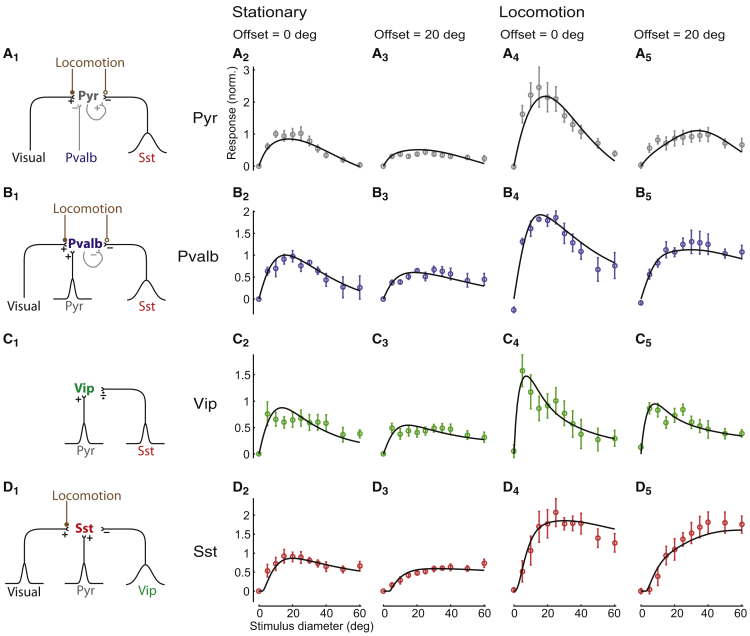
A Recurrent Network Model Accurately Predicts the Visual Responses of Each Cell Type(A1) Input synapses received by Pyr cells and their modulation by locomotion. Pyr cells receive feedforward visual excitatory inputs (e.g., from thalamus or other cortical layers) and subtractive inhibition from Pvalb and Sst cells. Locomotion increases the synaptic weights from external visual inputs to Pyr cells (filled circles) while decreasing recurrent Pyr-to-Pyr connections (empty circles). Pyr cells integrate from a broad pool of Sst cells (large Gaussian curve). Gray indicates connections that could be mathematically integrated out in the model when computing effective connections.(A2–A5) Model fit (black curves) of the size-tuning data during stationary periods (A2 and A3) and locomotion (A4 and A5), visualized for centered cells (offset = 0, A2 and A4) and off-center cells (offset = 20, A3 and A5). Error bars correspond to standard error.(B1) Input received by Pvalb cells. Locomotion boosts feedforward synaptic weights to Pvalb neurons while decreasing recurrent Pvalb-to-Pvalb synaptic weights.(B2–B5) Same as (A2)–(A5), but for Pvalb cells.(C1) Input received by Vip cells. Vip cells receive divisive inhibition from Sst cells; no modulation of these synapses by locomotion is required to obtain a good fit.(C2–C5) Same as (A2)–(A5), but for Vip cells.(D1) Input received by Sst cells. In addition to inputs from Pyr and Vip cells, Sst cells receive a feedforward input that we propose to originate from thalamus or other cortical layers. As with Pyr and Pvalb cells, the strengths of these synapses are boosted by locomotion.(D2–D5) Same as (A2)–(A5), but for Sst cells.